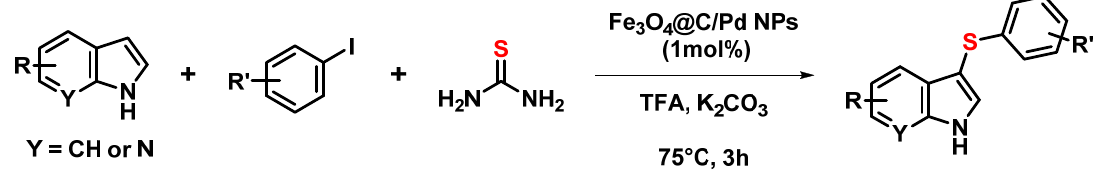
Cellulose deposited over Fe 3 O 4 NPs has been charred at high temperature under inert